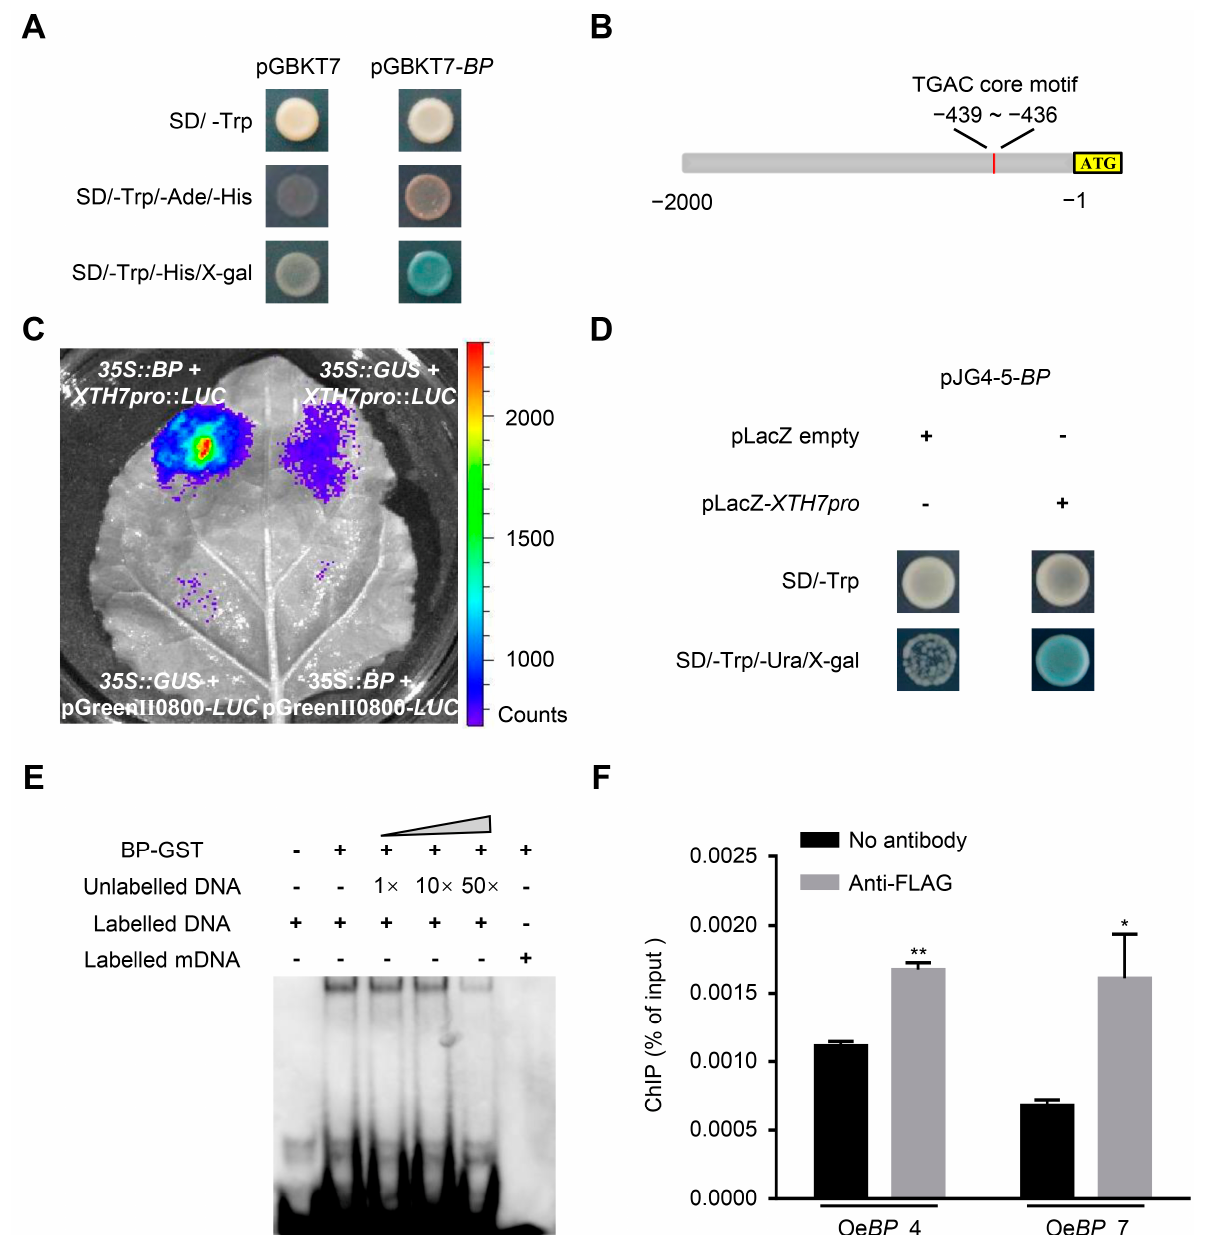
Figure 4. BP directly binds to the promoter of XTH7 . ( A ) Transcriptional-activity assay of BP. The full length CDS of BP was fused in frame to the GAL4 DNA-binding domain and transformed into yeast-strain Gold Yeast. The pGBKT7 vector was used as the negative control. ( B ) Schematic diagram of the promoter of XTH7 . The TGAC core motif is shown in red. ( C ) BP activates the expression of XTH7pro:LUC. The effector ( 35S:BP ) and reporter ( XTH7pro:LUC ) vectors were co-transformed into N. benthamian leaves. Tobacco leaves injected with pGreenII0800- LUC + 35S:GUS , XTH7pro:LUC + 35S:GUS , pGreenII0800- LUC + 35S:BP were used as controls. ( D ) Yeast one-hybrid assay showing the binding of BP to the promoter of XTH7 . ( E ) BP binds to the promoter of XTH7 in EMSA. The probes were labelled with biotin. ( F ) BP combines with the promoter of XTH7 in the ChIP assay. The bars indicate means ± sd of three independent replicates. * p < 0.05, ** p < 0.01 (Student’s t test).